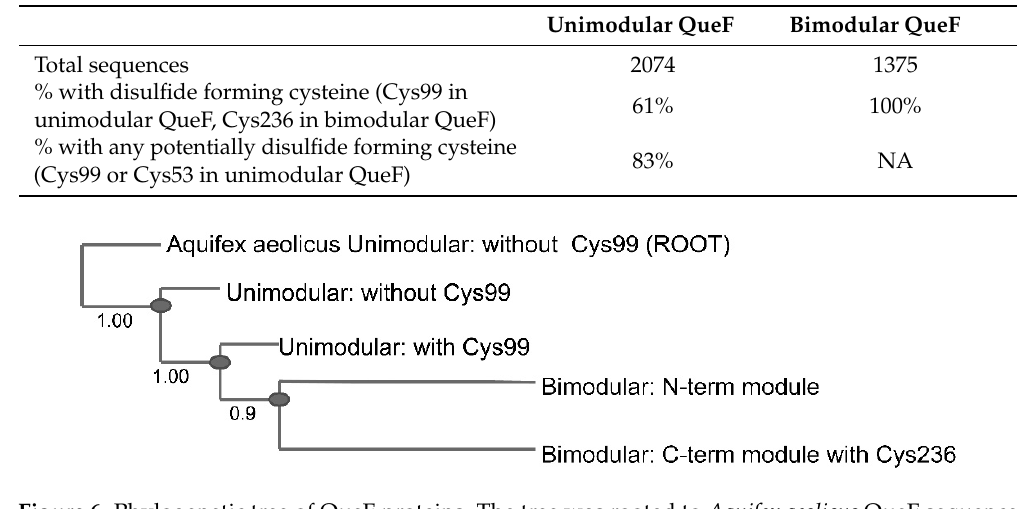
Figure 6. Phylogenetic tree of QueF proteins. The tree was rooted to Aquifex aeolicus QueF sequence (unimodular QueF with no Cys99). Numbers indicate the posterior probability value.